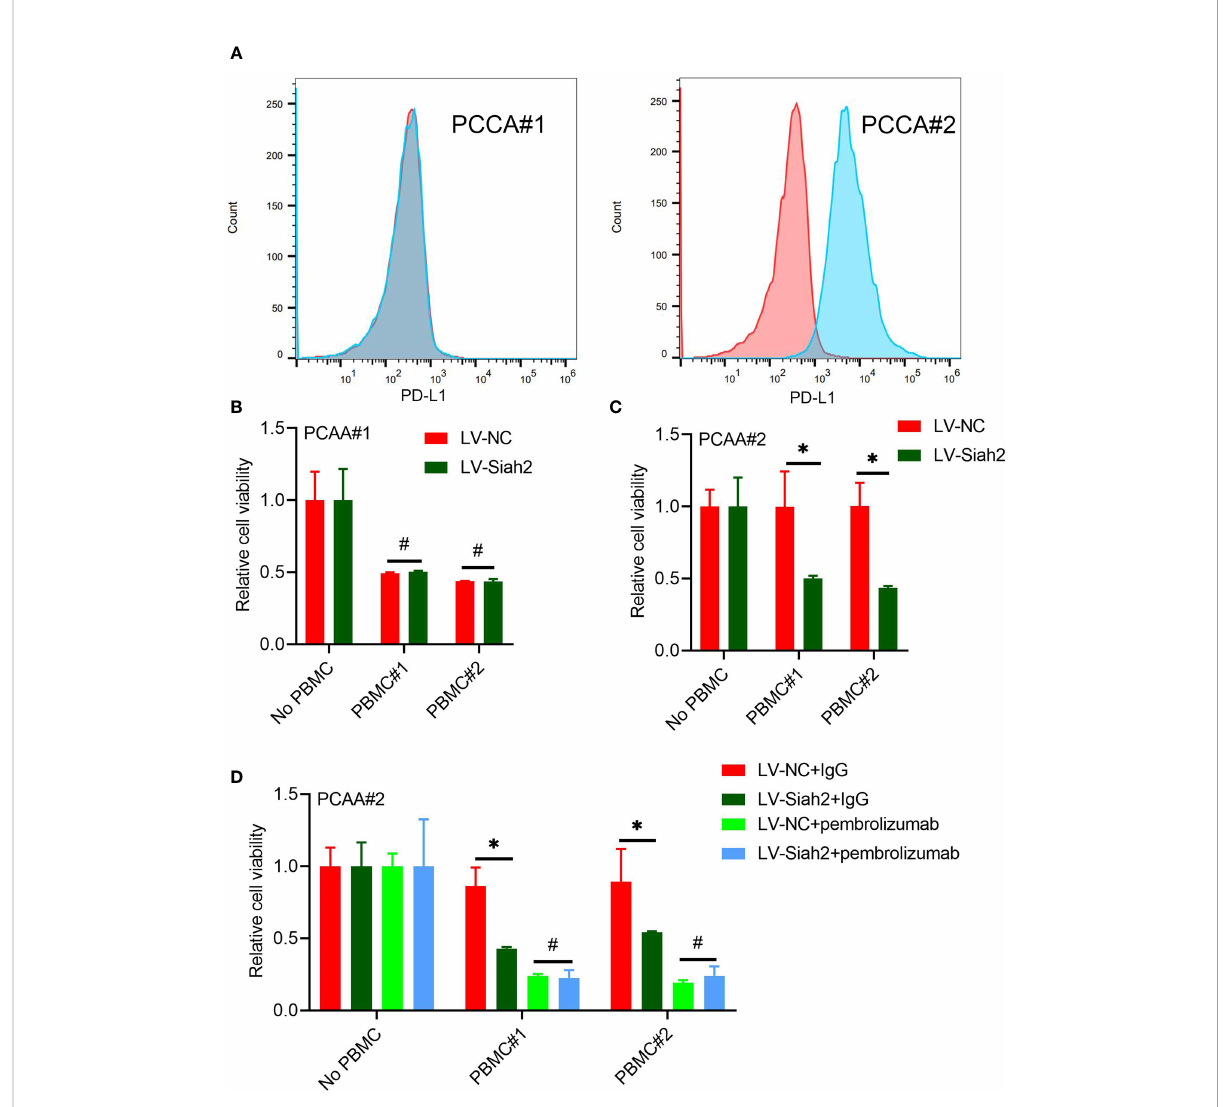
FIGURE 7 Siah2 enhanced antitumor T-cell immunity in a PD-L1 – dependent manner. (A) , FCM detected the cell membranous PD-L1 level of PCCA#1 and #2. (B, C) , CCK8 assay detects the killing of PCAA#1 LV-NC/LV-Siah2 by activated HPBMC in PCCA#1 and PCCA#2 cells. The ratio of PBMC to tumor cell numberwas 4 to 1, n = 3. (D) , CCK8 assay detected the killing of tumor cells by activated HPBMC after Pembrolizumab or 10 m g/mL IgG treatment. PCAA#2-LV-NC/LVMETTL14 were co-cultured in the presence or absence of HPBMC for 24 h at the ratio of HPBMC to tumor cell number of 4 to 1, n = 3. Mean ± SEM of three independent experiments. *P < 0.05; #P >